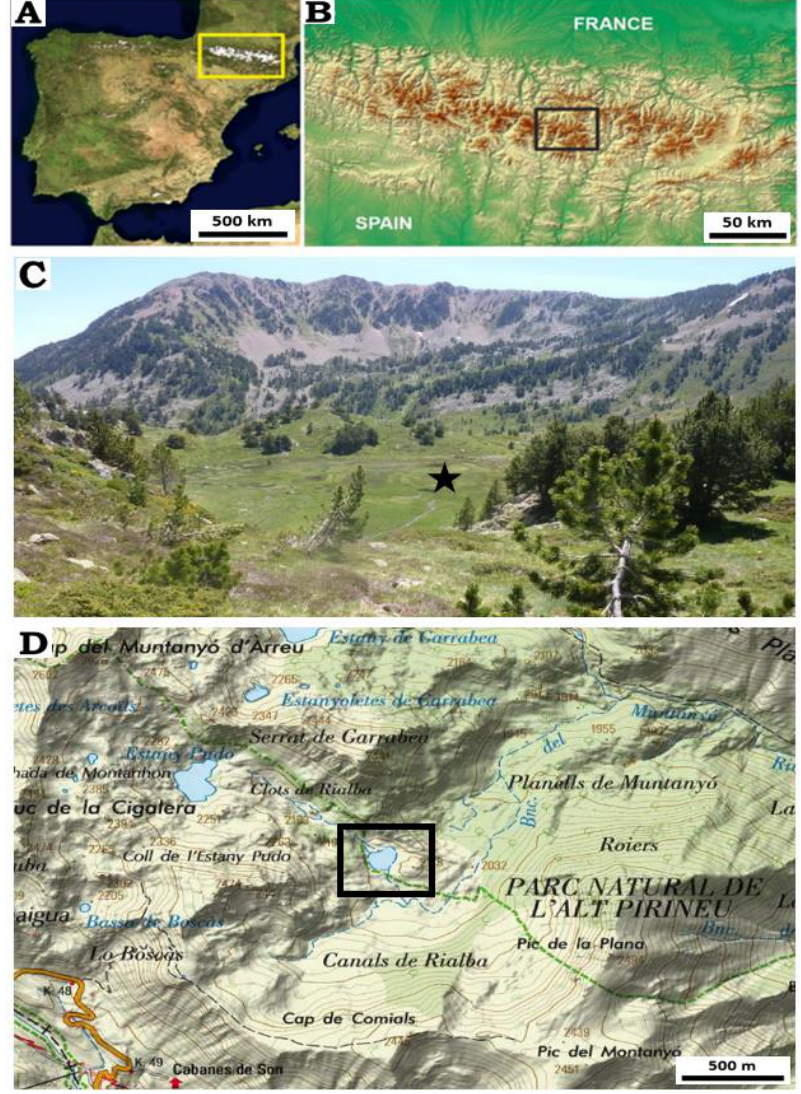
Figure 1. Geographical maps and pictures of the Clots de Rialba peat bog. ( A ): Pyrenees range in the northern Iberian Peninsula (yellow square). ( B ): location of the peat bog in the axial Pyrenees range (black square). ( C ): summer scenic view of the Clots de Rialba peat bog with a black star in the sampling point. ( D ): cartographical detail (black square). Source: ICGC.